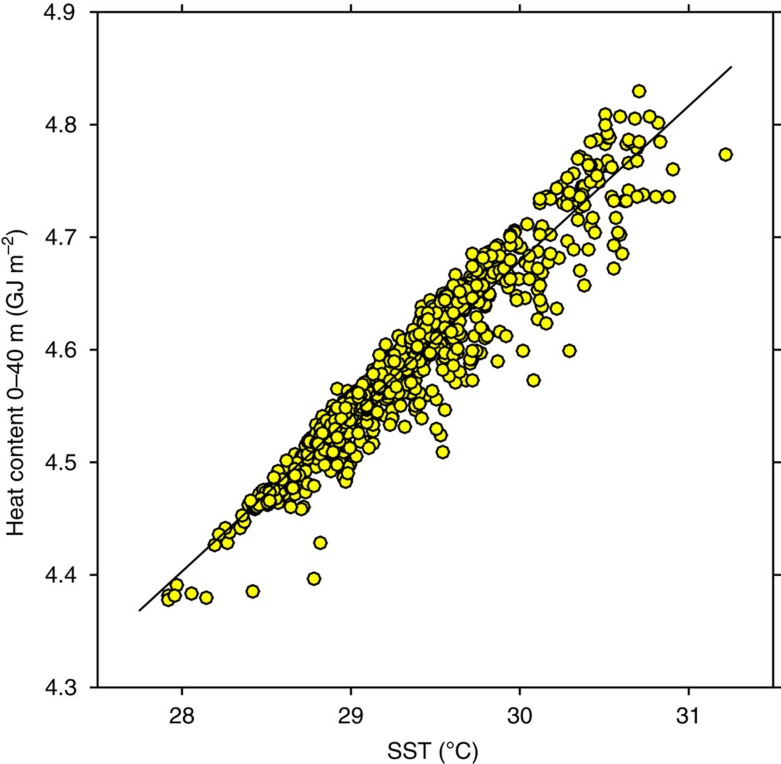
Heat content versus SST.Heat content (HC) derived from daily-averaged temperature profiles (integrated over the upper 40 m) and SST at the RAMA mooring at 0°, 80° E between late 2008 through 2012. The 905 data points are significantly correlated, r=0.95 [0.94, 0.96] where the values in [ ] represent 95% confidence limits. The linear regression indicated by the black line is HC=0.14 × SST+0.54.